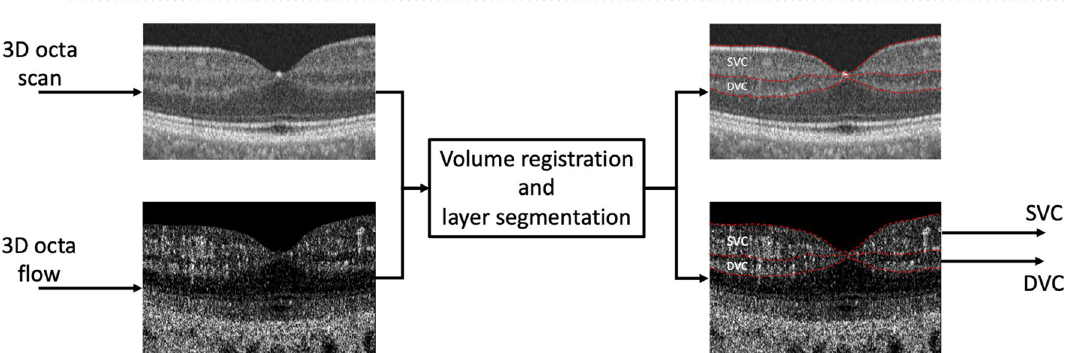
Figure 4. Schematic representation of volume registration and layer